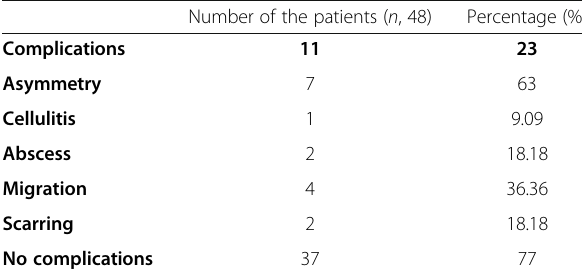
Table 3 Distribution of the studied patients according to the injectable fillers